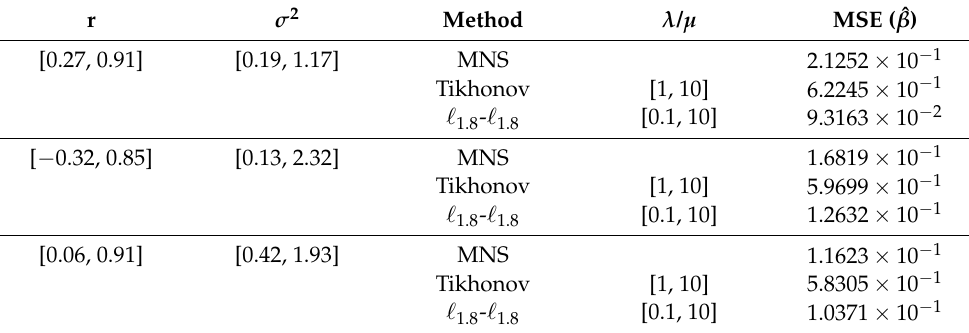
Table 3. Results for X 25 × 51